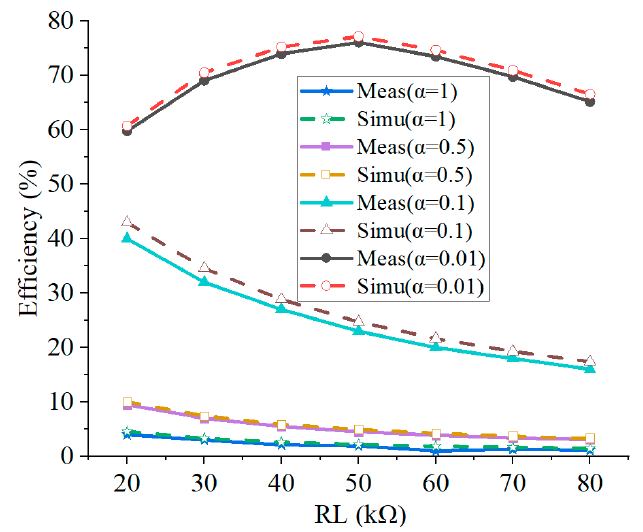
Figure 9. Simulation and measurement of rectifying efficiency at the same average input power.